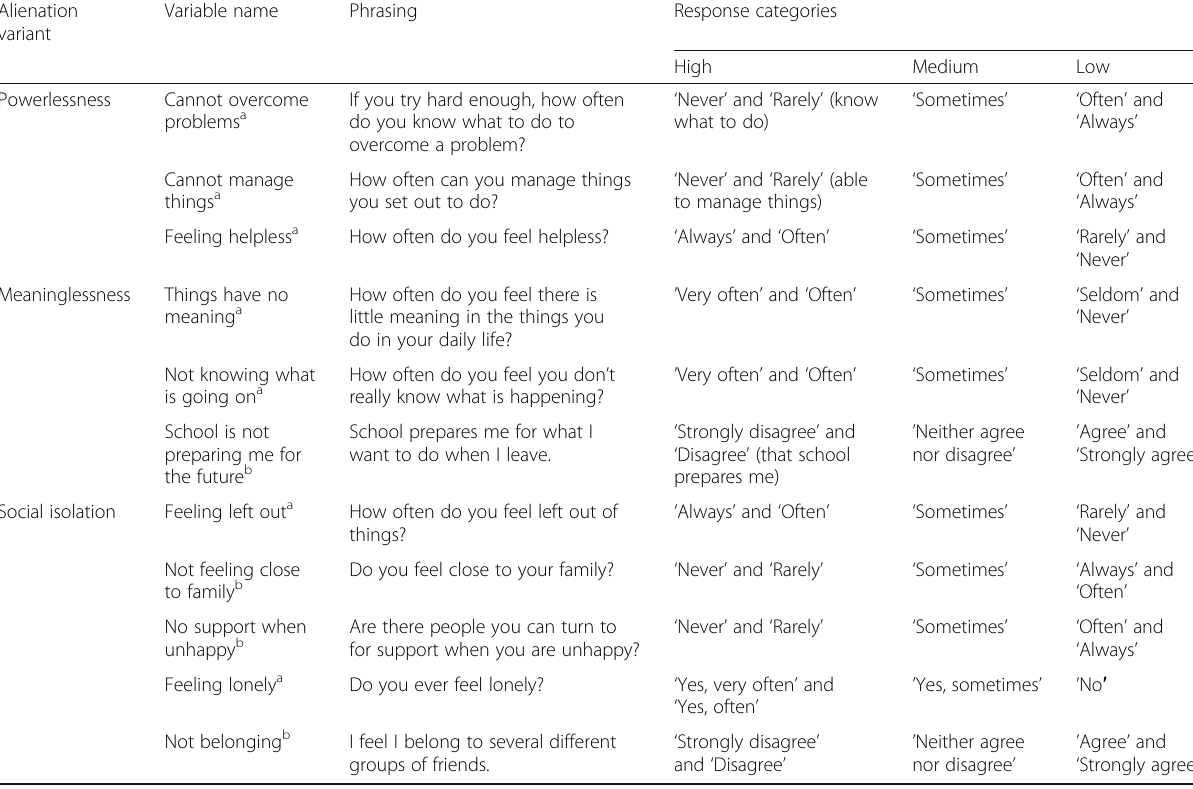
Table 1 Phrasing and trichotomization of variables translated into English Alienation